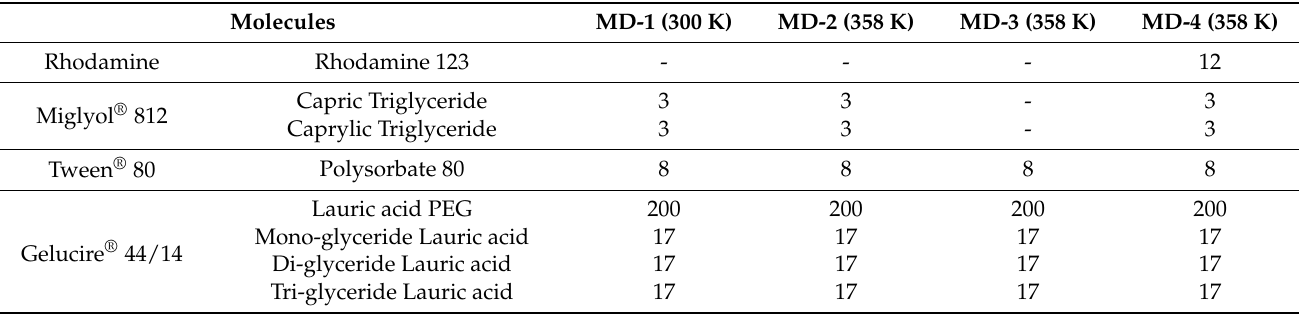
Table 5. Molecules used in the simulation of mixed NLC